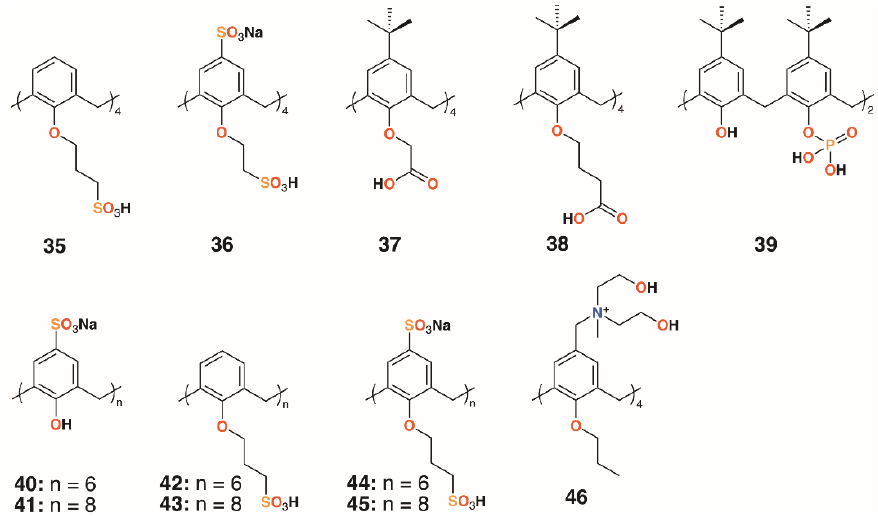
Figure 9. Coleman’s AgNP-capping calixarenes and Nostro’s drug-delivering calixarene.